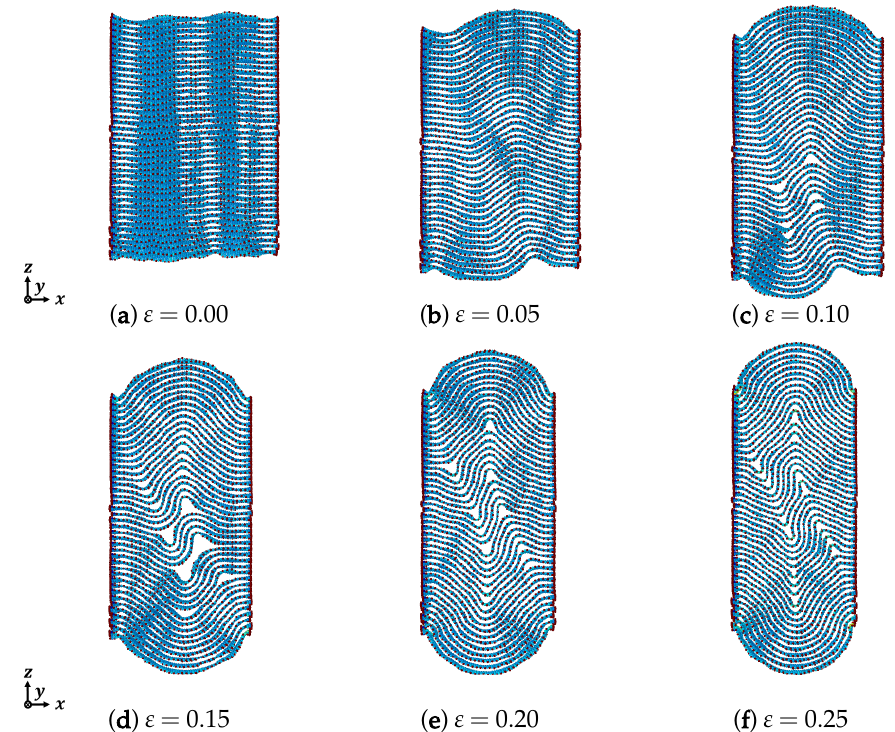
Figure 7. Deformation of zigzag graphite under compression ( n = 40).